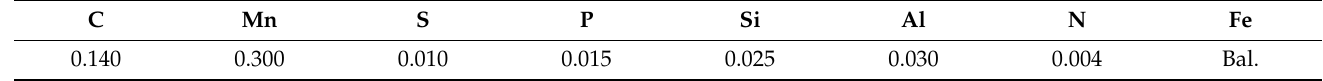
Table 1. Composition of the commercial steel used in this study (wt.%).